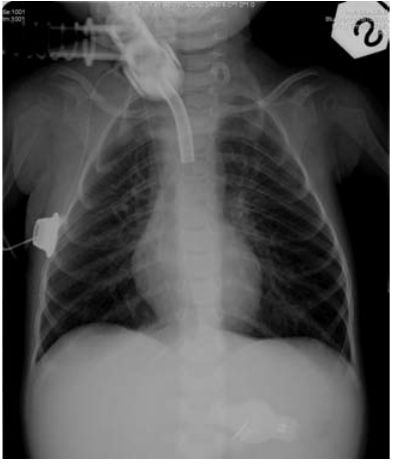
years.Figure 5. Case #3. Initial tip